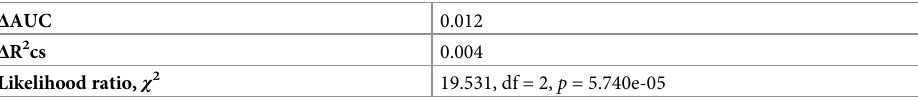
Table 4. Comparing the full and the simple